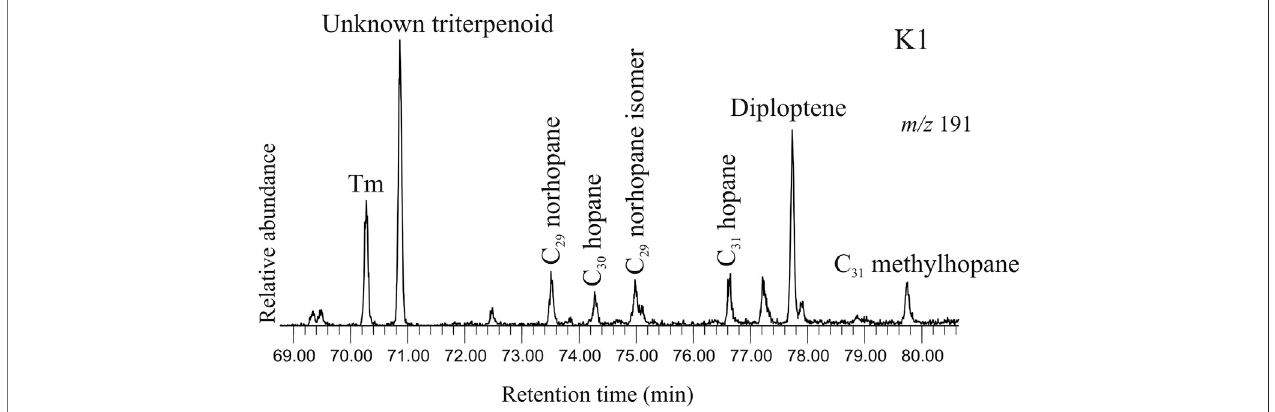
FIGURE 6 | Selected ion chromatogram at m/z 191 depicting the peaks for the hopanoids in the saturated hydrocarbon fraction extracted from the studied sediment(K1, ∼ 369 cal yrBP).Thehopanoidspectrum comprisesboth unsaturated (diploptene) andsaturatedcompounds viz.Tm,C 29 norhopane andits isomer,C 30 hopane, C 31 hopane and C 31 methylhopane.